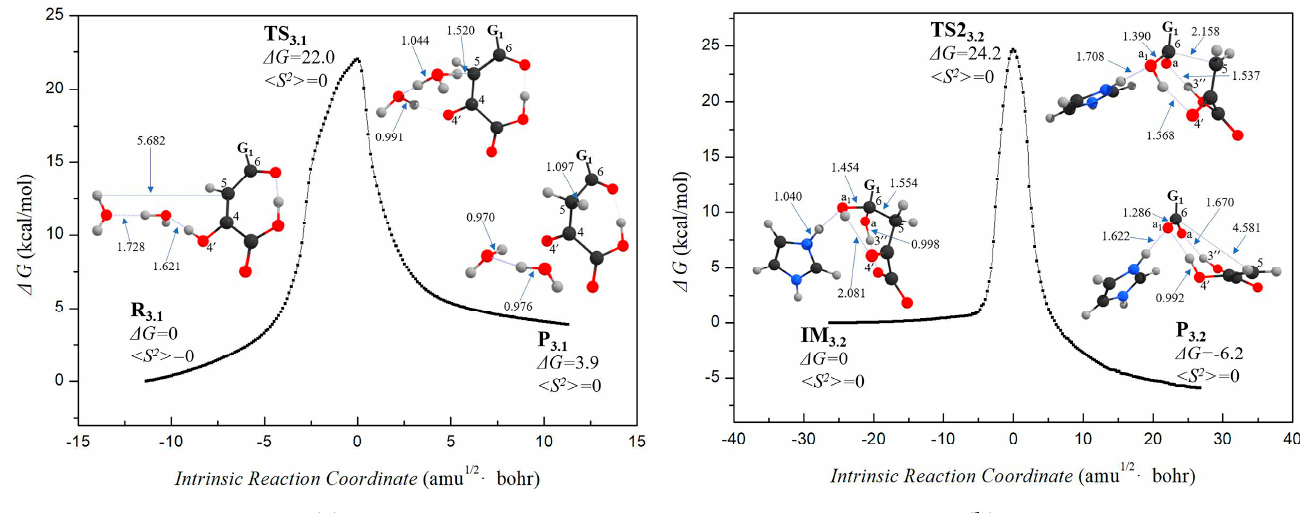
Figure 6. Under the calculated level of CAM-B3LYP/6 − 31+G**, ( a ) the reaction potential energy curve and the key geometric parameters of each stable point of ( a ) the isomerization process of caffeoyl pyruvic acid (3.1) and ( b ) the hydrolysis process of caffeoyl pyruvic acid (3.2). The reaction mechanism can be seen in Scheme 7. Group G 1 is shown in Scheme 1.